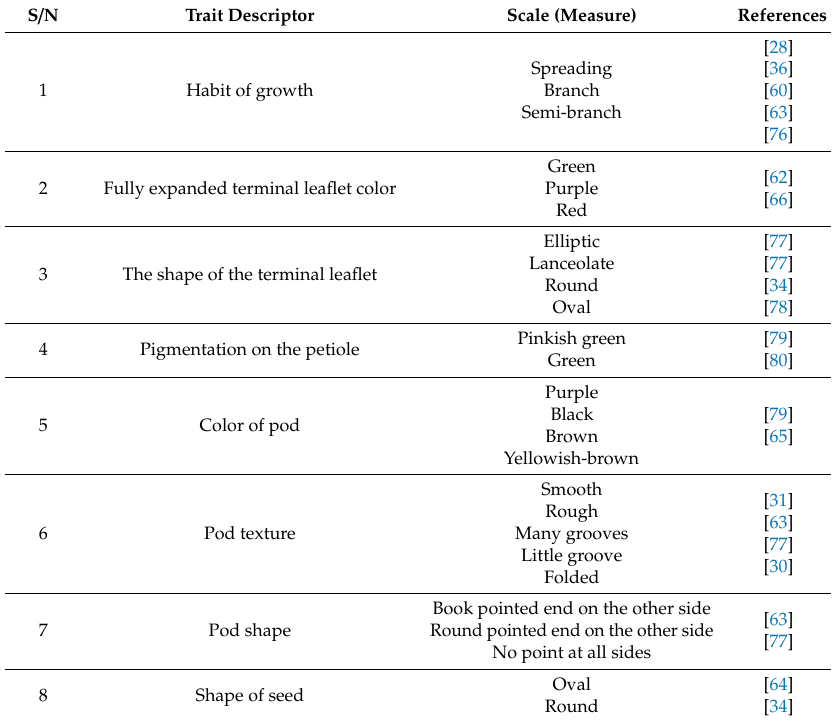
Table 2. Select documented qualitative morphological variants in Bambara groundnut germplasm. S / N Trait Descriptor Scale